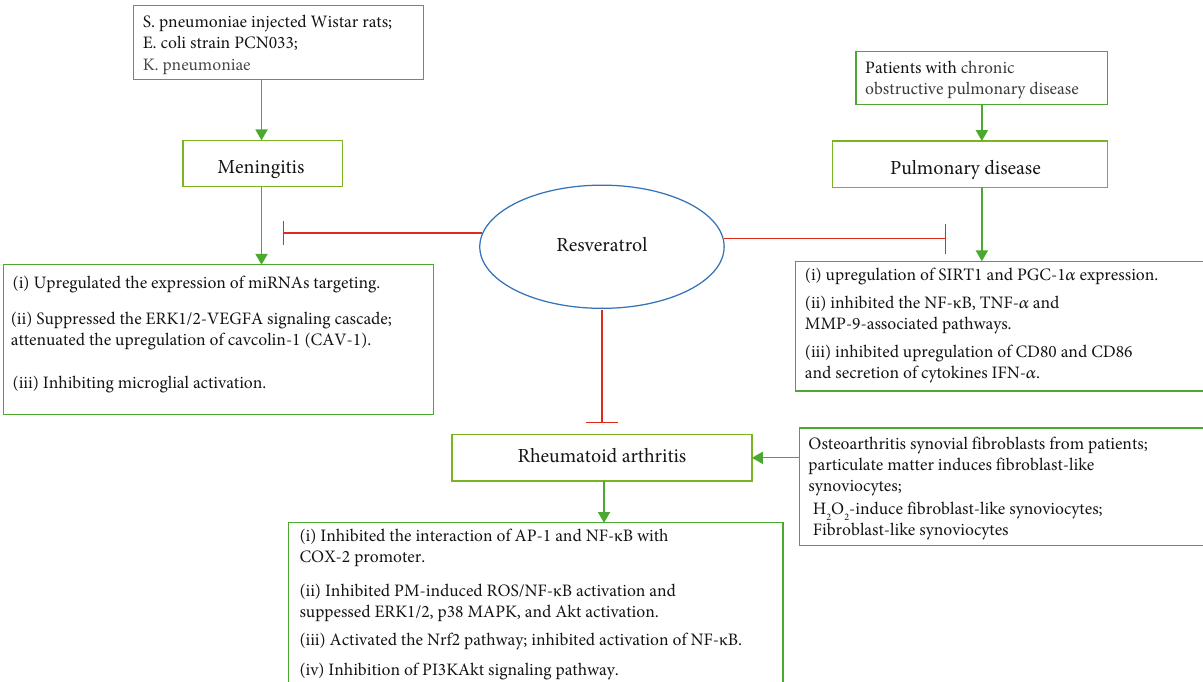
Figure 2: Mechanisms by which resveratrol regulates various in fl ammatory